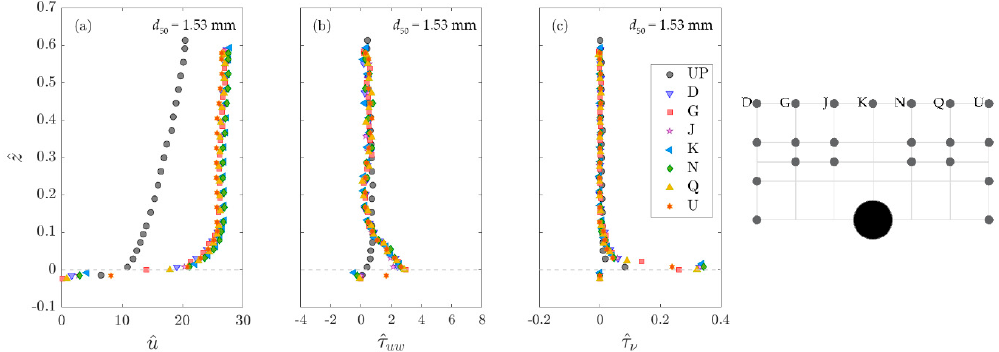
Figure 8. Vertical distributions of ( a ) dimensionless time-averaged velocity, ( b ) dimensionless Reynolds shear stress, and ( c ) dimensionless viscous shear stress at y = 0 in Run 1.